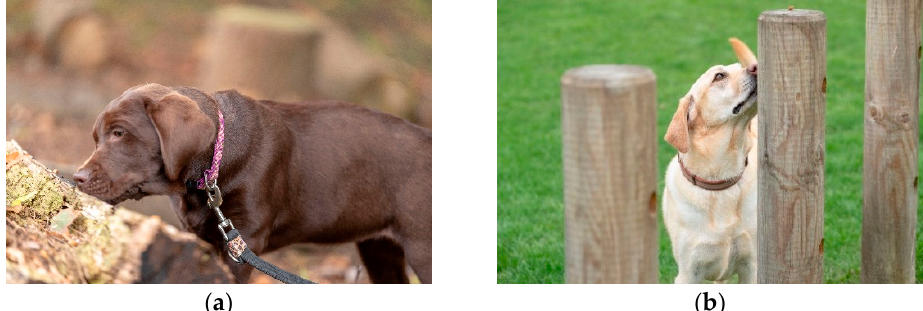
Figure 2. ( a ) A dog at Waltham having a slow walk through a wooded area. ( b ) A dog at Waltham experiencing scent play during an outdoor social session.